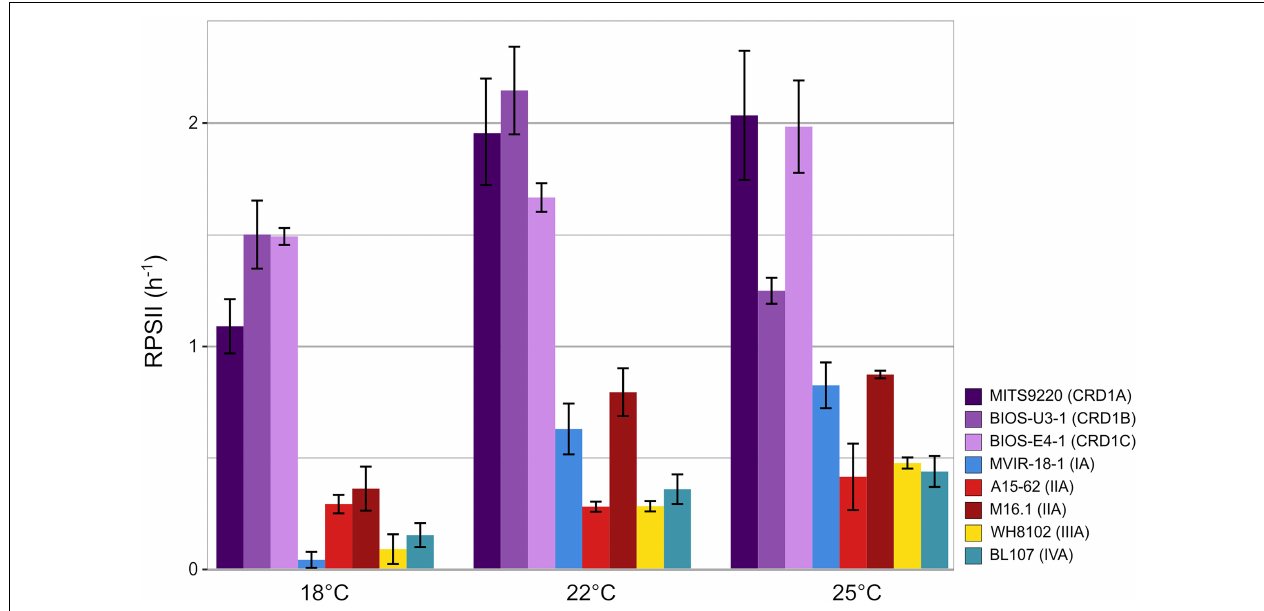
FIGURE 4 | Variation with growth temperature of cumulative photosystem II repair rate (RPSII) of CRD1 vs. clade I, II, III, and IV strains. The insert indicates the strain names and their corresponding ESTU ( sensu Farrant et al., 2016) between